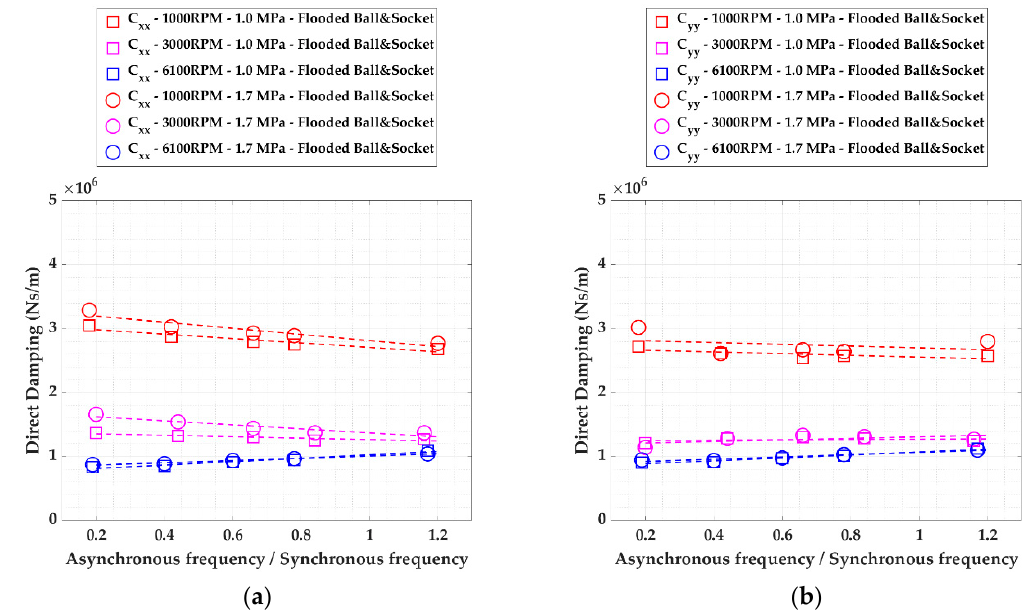
Figure A4. Flooded Ball & Socket Pivot bearing asynchronous direct coefficients at various speeds for 1.0 MPa and 1.7 MPa: ( a ) C xx , ( b ) C yy .